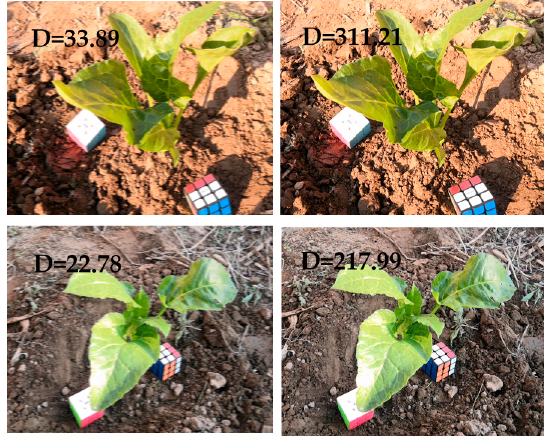
Figure 5. Comparison of blurred images (left) to normal images (right). D represents the degree of blurriness of the image. blurriness of the